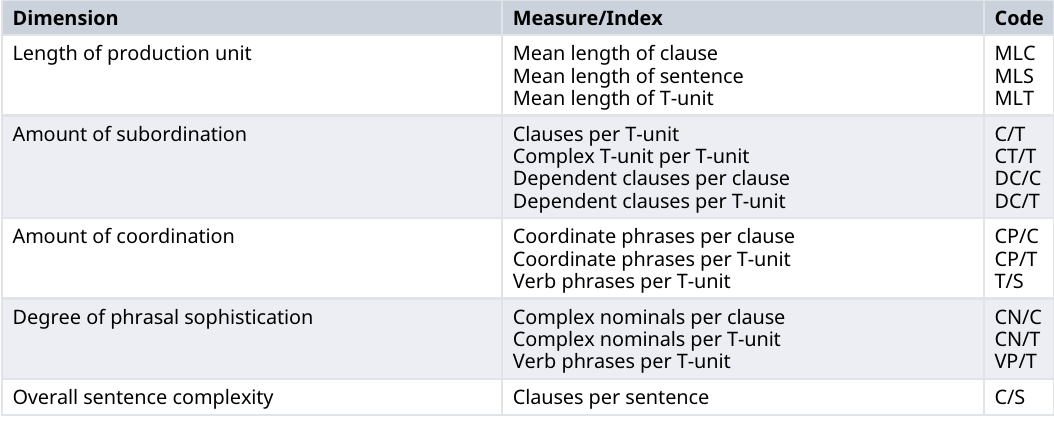
Table 1. Lu ’ s (2010) 14 indices for language two (L2) syntactic complexity with codes.